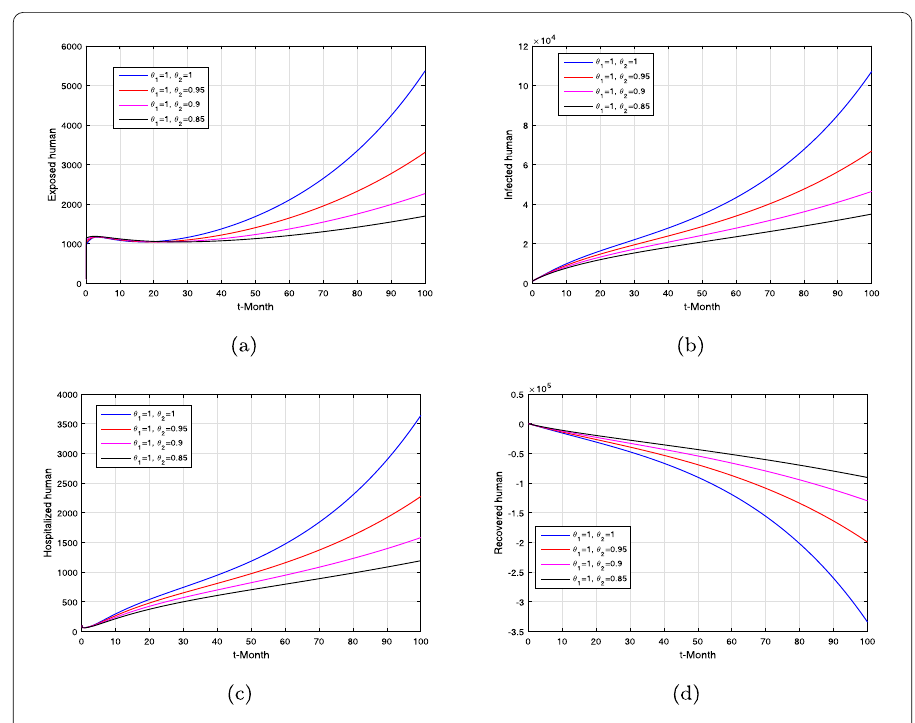
Figure 5 Simulation of the fractal-fractional model (10) when θ 2 = 1,0.95,0.9,0.85 and fractional order θ 1 = 1 where ( a ) exposed humans, ( b ) infected humans, ( c ) hospitalized humans, ( d ) recovered humans